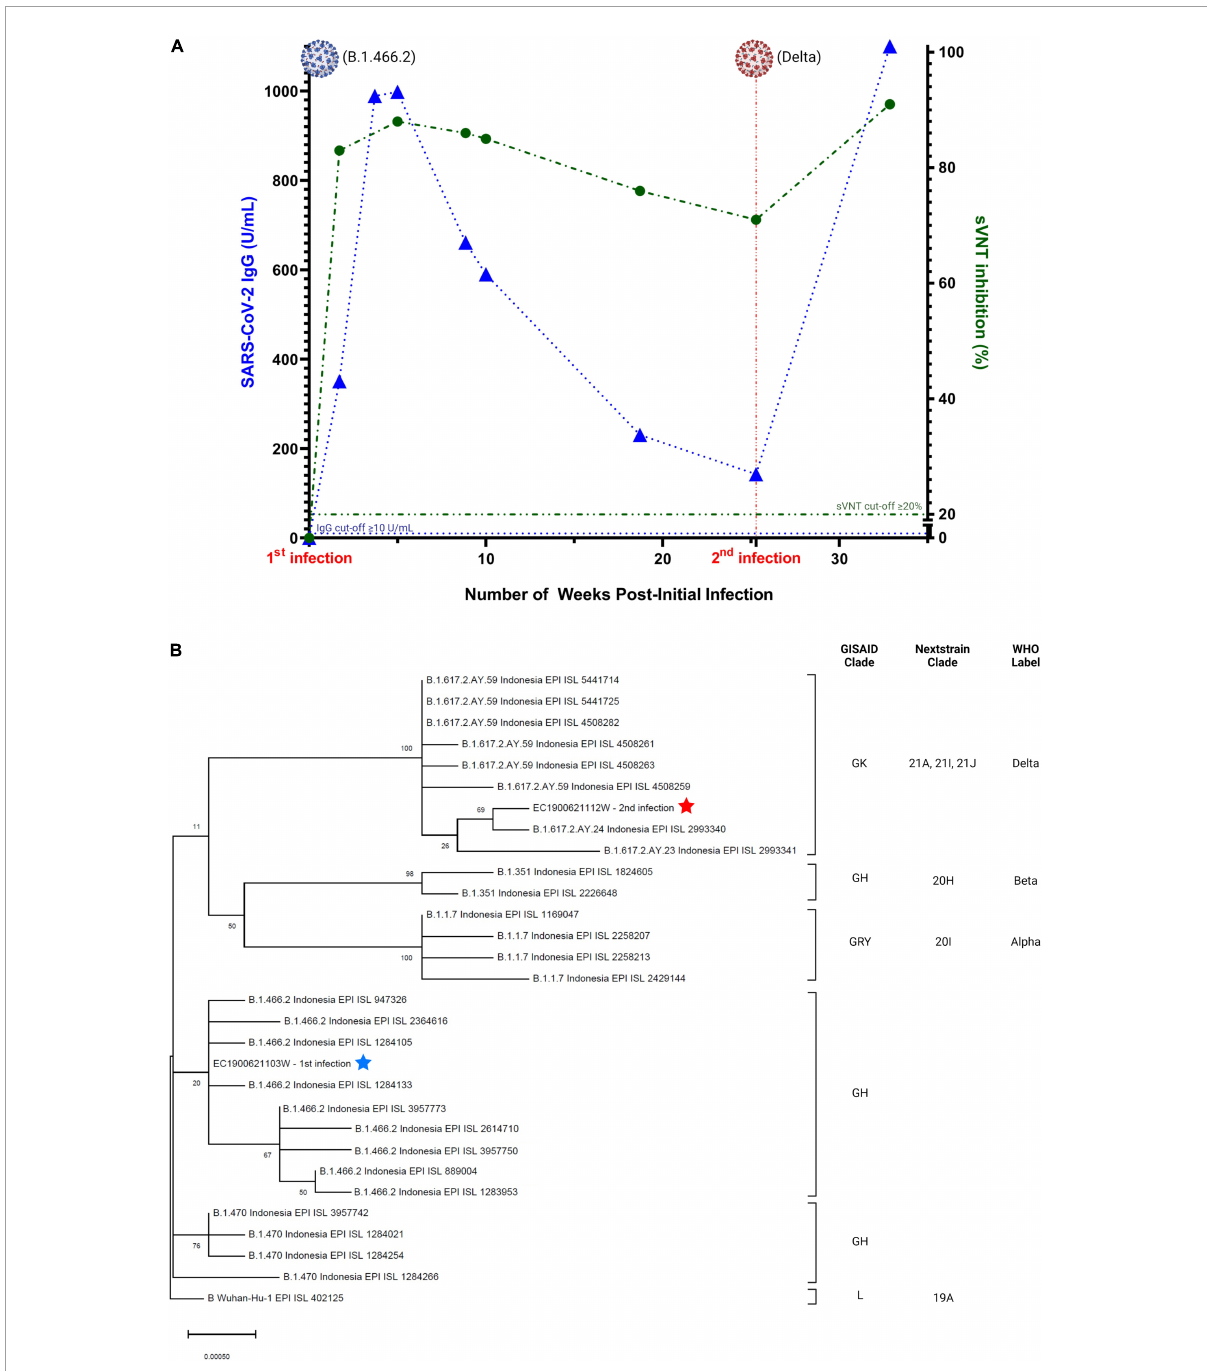
FIGURE2 (A) Serial serology of SARS-CoV-2 IgG (blue) and neutralizing antibody (green). Image was created with GraphPad Prism 9.3.1 and BioRender.com, (B) phylogenetic analysis of SARS-CoV-2 genomes showing the relationship between the two distinct variants of two infection episodes. The tree was constructed by maximum likelihood method. Clade information as inferred by GISAID, Nextstrain, and Pangolin nomenclatures, are shown. The reference genome Wuhan-Hu-1 (GenBank accession number NC_045512.2) is used as the root of the